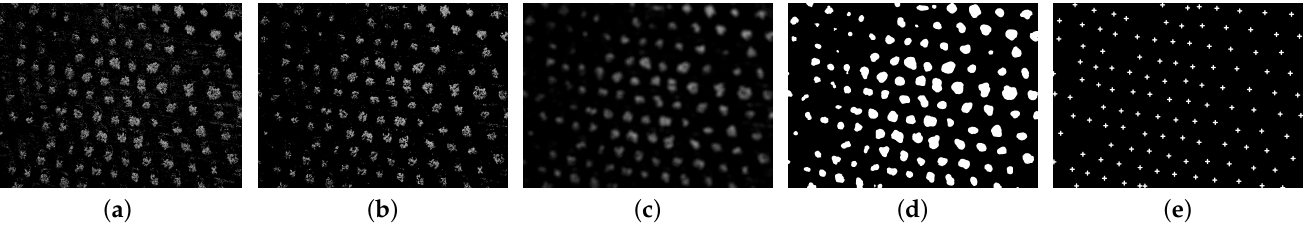
Figure 6. Images resulting from each stage of the OTCM block associated with capture 0. The resulting image of each stage is the one received as input by the next stage. ( a ) Clipping and normalisation. ( b ) Noise filtering. ( c ) Density computation. ( d ) Segmentation. ( e ) Centroid